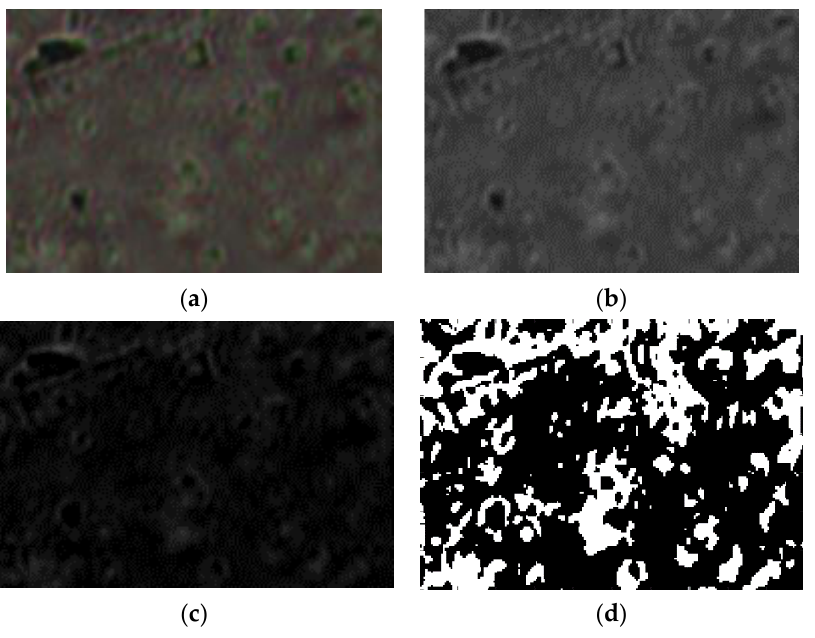
Figure 7. Primary processing of the selected image U 1 . ( a ) — original image (the entire portion); ( b ) —